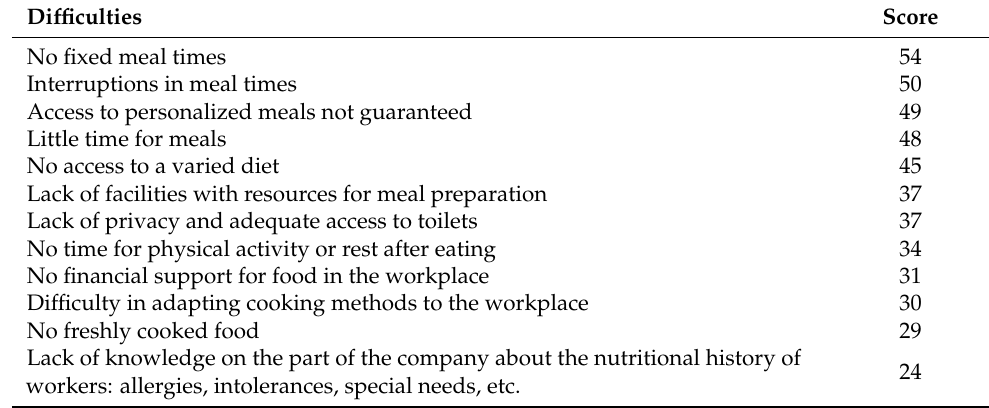
Table 3. Difficulties in the work environment related to IBD.